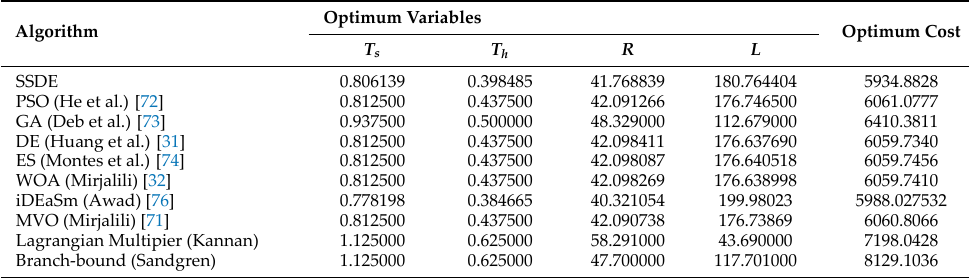
Table 7. C omparison of r esults of t he p ressure v essel d esign p roblem. Table 7. Comparison of results of the pressure vessel design problem.